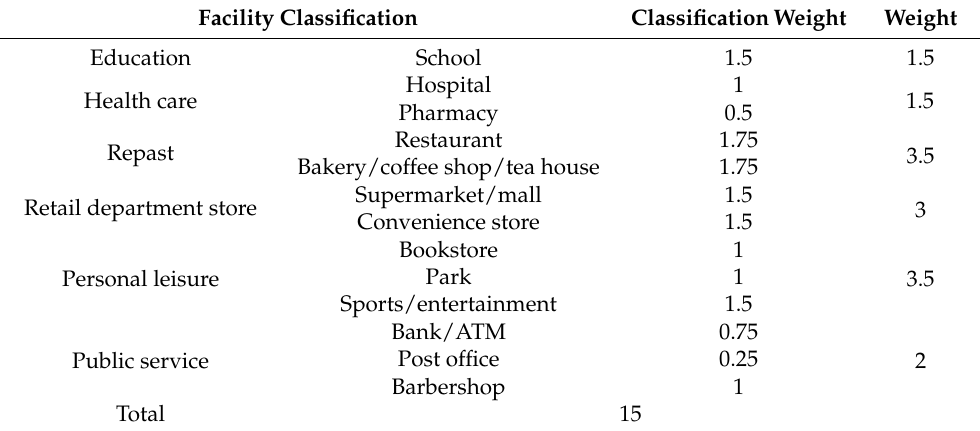
Table 2. Improved facility classification and weight